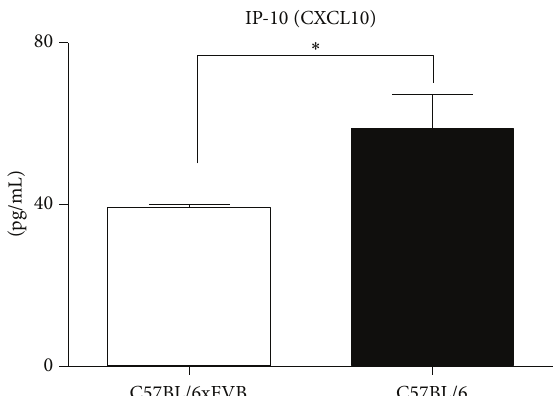
Figure 4: Concentrations of chemokines in serum. Concentrations of MIP-2 and IP-10 were higher in C57BL/6J mice than in C57BL/6JxFVB mice. Concentrations of MCP-1, MIP-1 𝛽 , RANTES, eotaxin, KC, LIX, and MIG did not differ between C57BL/6J and C57BL/6JxFVB mice. Dashed line indicates the detection